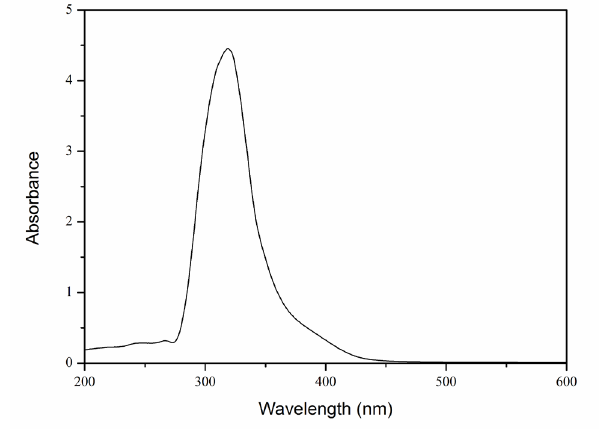
Figure 7 : The UV-vis spectrum of 1